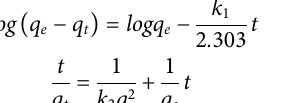
FIGURE 4 | Cyclic adsorption-desorption results.